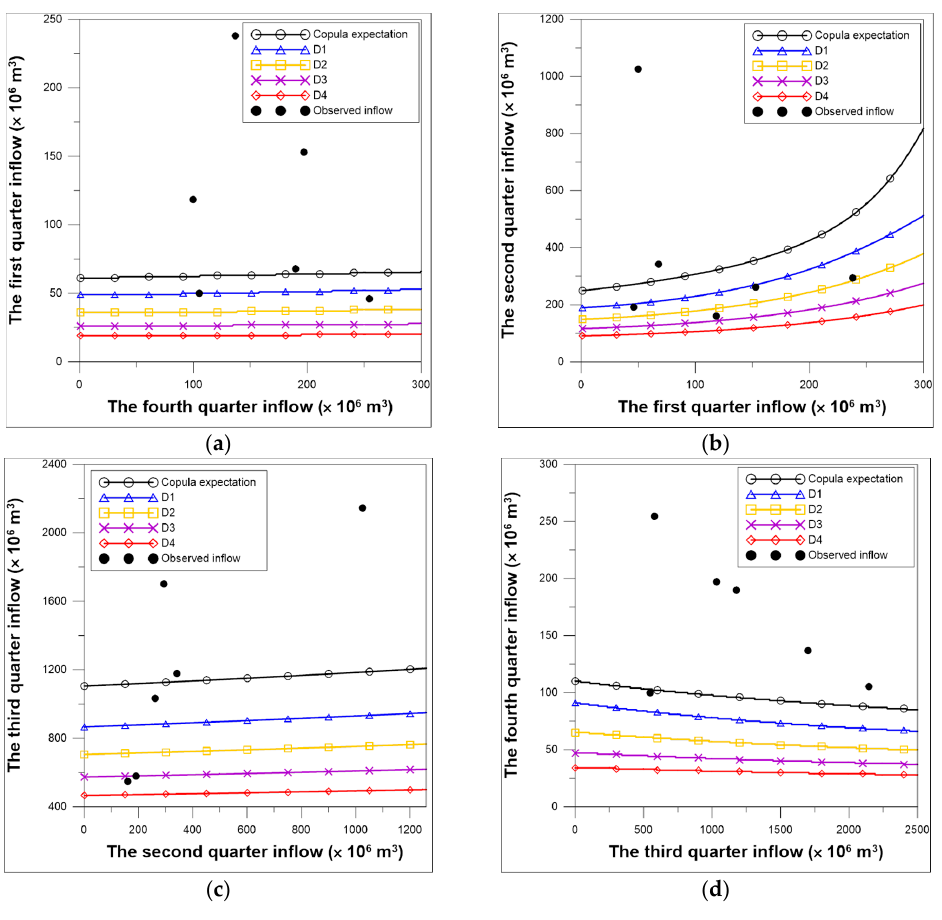
Figure 9. Quarterly inflow forecasting curves conforming to drought stages for the Soyanggang dam: ( a ) first quarter; ( b ) second quarter; ( c ) third quarter; ( d ) fourth quarter.